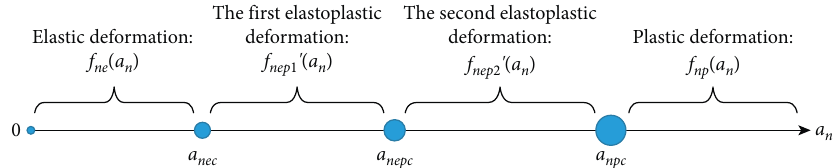
Figure 3: The diagram of the deformation law of a single asperity and the relationship between each critical contact